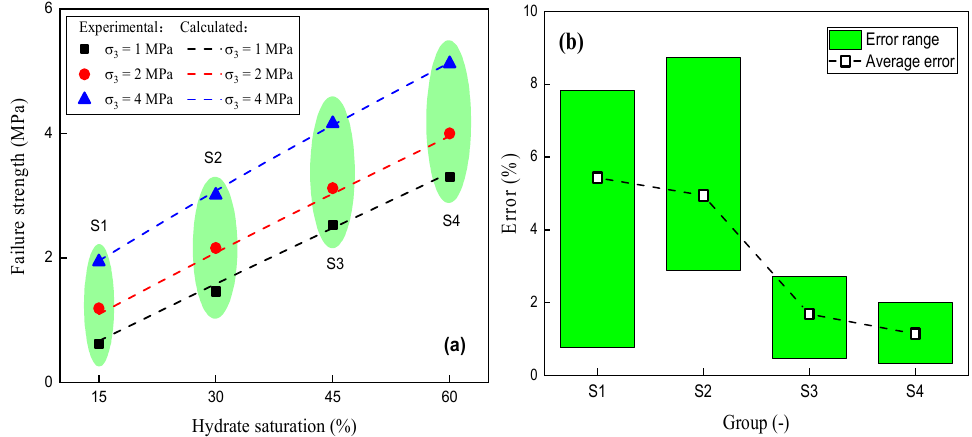
Figure 10. Comparison between experimental data and calculated results: ( a ) Predicted failure strength; ( b ) Error.